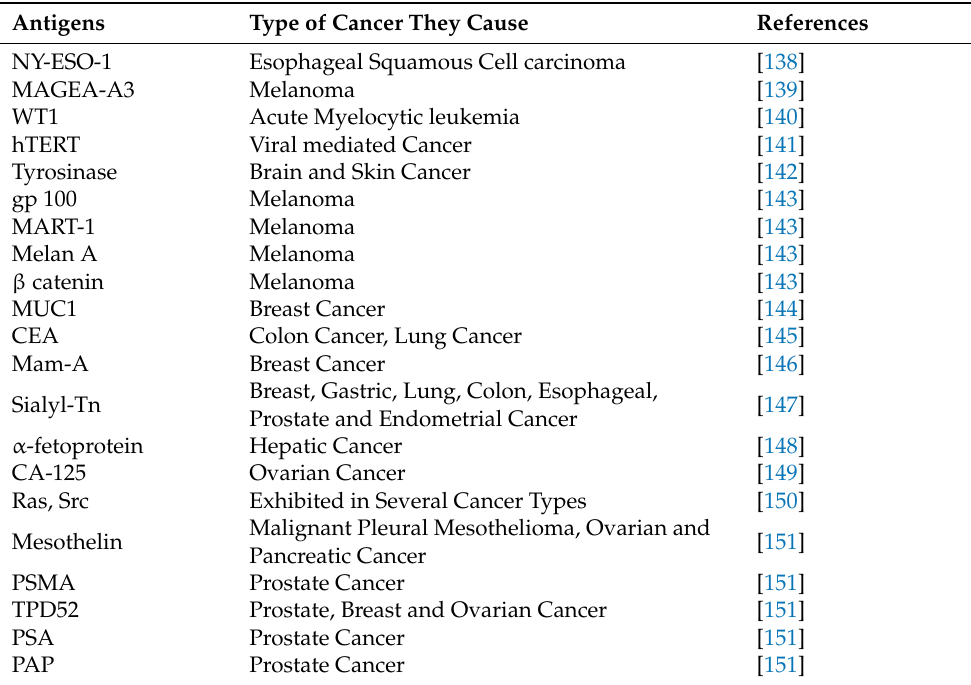
Table 1. Antigens and type of cancers they cause. Tumor antigens’ classification depends on their molecular structure and their origin, and, based on these properties, we can classify the tumor antigen into following categories of tumor-associated antigens (TAAs): (i) mutation products of specific genes (In breast cancer, the mutation of Her2 and Ras causes 10% of the carcinomas); (ii) oncogenic virus antigens; (iii) abnormal cellular proteins; (iv) types of oncofetal antigens; (v) classes of glycolipids and glycoproteins; (vi) types of differentiated tissue-specific